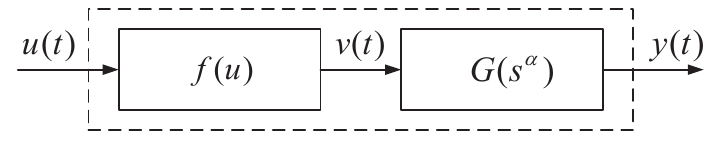
Figure 1. Fractional-order Hammerstein